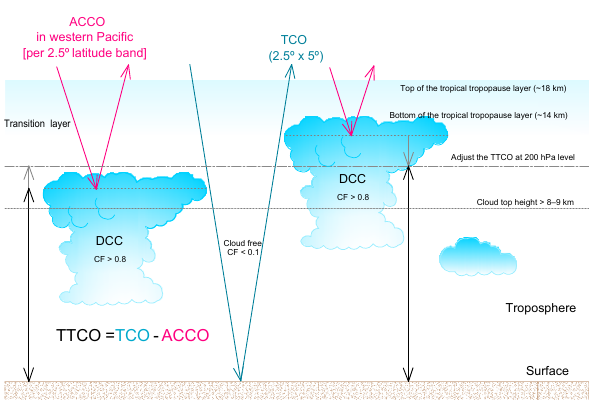
Figure 1. Illustration of the convective clouds differential (CCD) technique. DCC are the deep convective cloud, CF is the cloud frac- tion, ACCO is the above-cloud column of ozone, TCO is the total column of ozone and TTCO is the tropical tropospheric column of